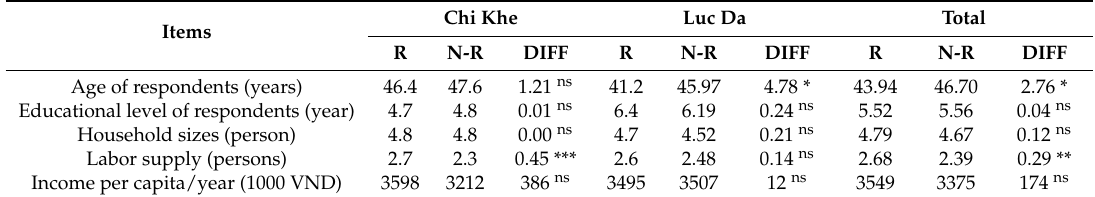
Table 5. Demographic characteristics of respondent households in Con Cuong District, Nghe An Province,